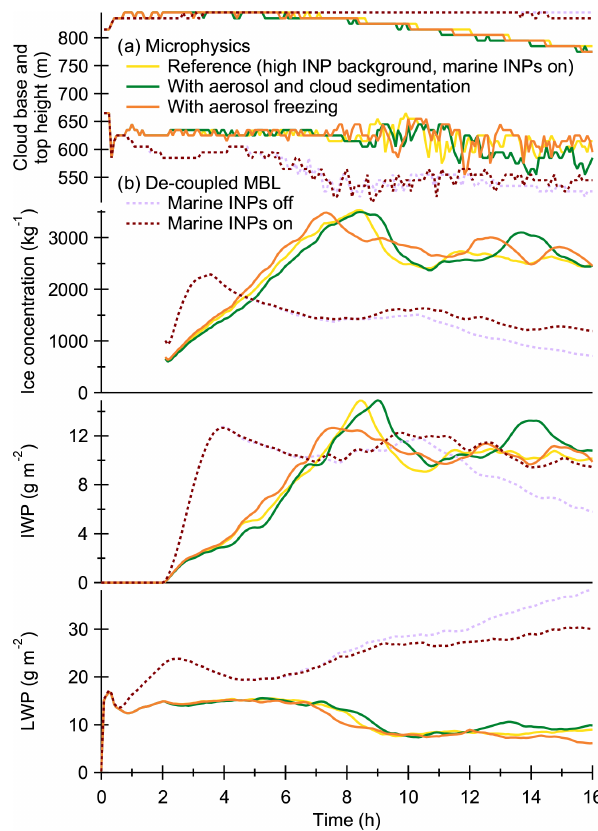
Figure 9. Sensitivity tests related to (a) microphysics (solid lines) and (b) decoupled marine boundary layer (MBL, dashed lines). The microphysics tests include aerosol and cloud droplet sedimentation or aerosol freezing switched on when compared with the reference case where they are disabled. The decoupled MBL tests includes simulations with modified initial temperature and humidity profiles when marine INP emissions are off or